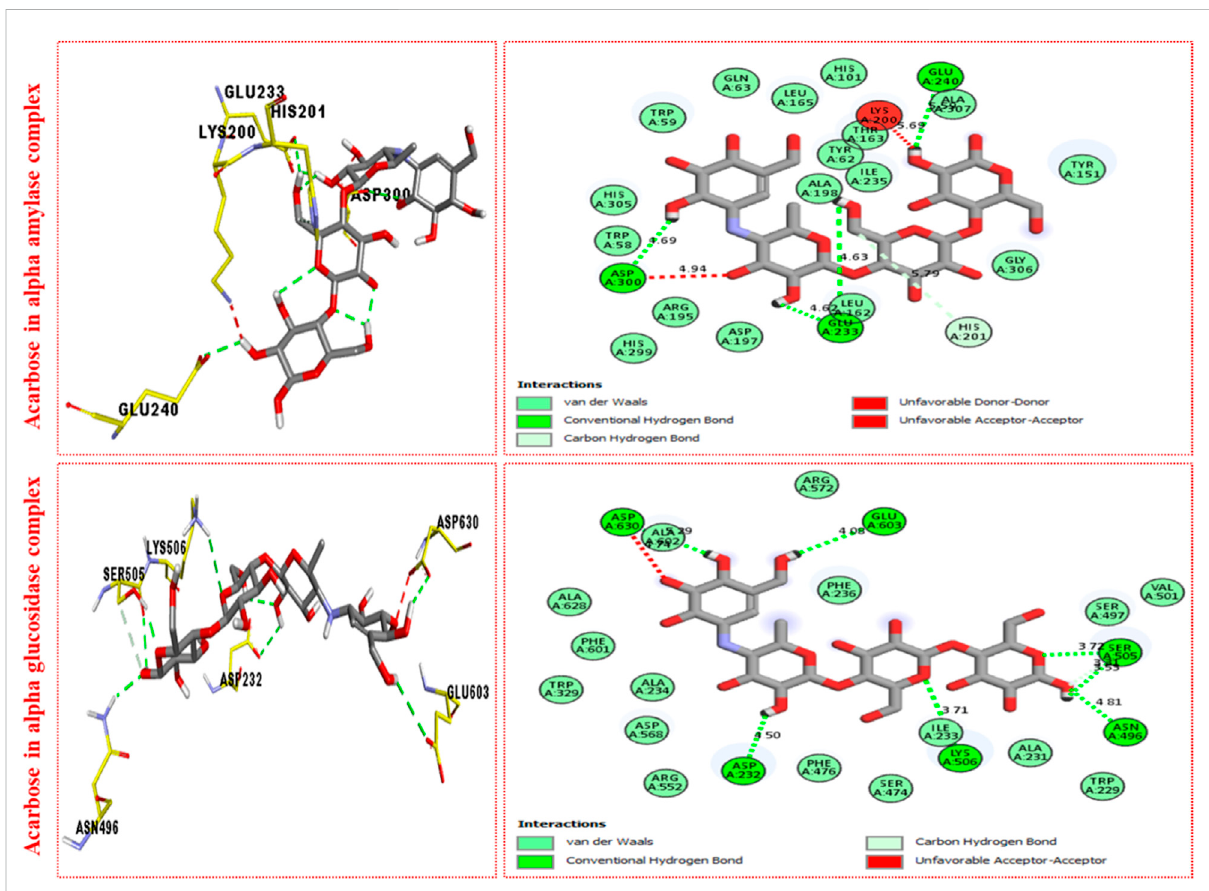
FIGURE 5 PLIpro fi leindicatesthecorrespondingsurfaceof α -amylaseand α -glucosidaseenzymesandtheirinteractionswiththestandardacarbosedrug.